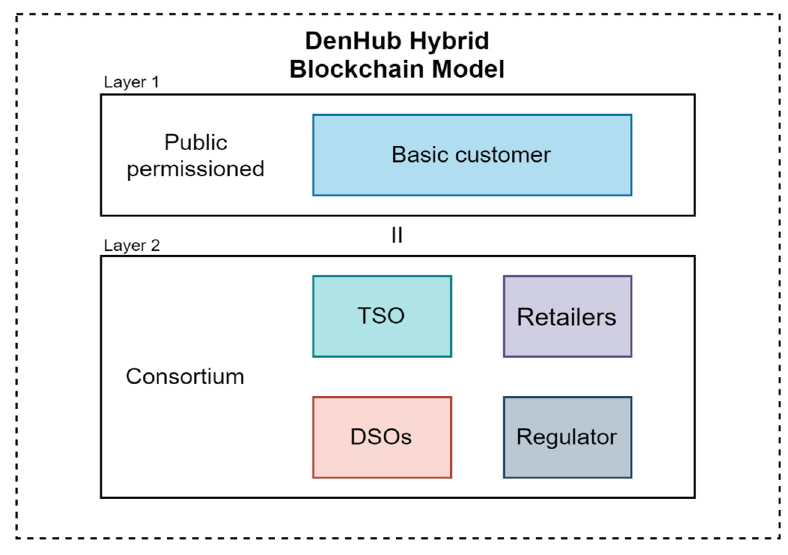
Figure 6. The DenHub Hybrid Blockchain Model.